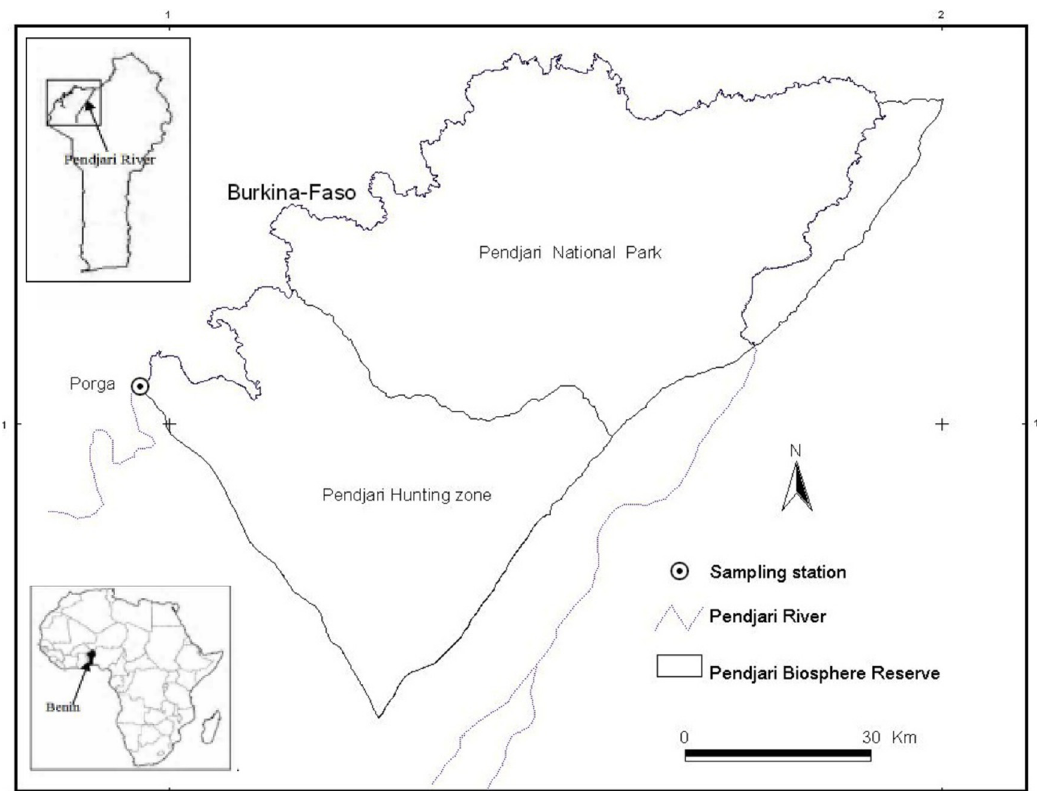
Fig. 1. Location of sampling station in the Pendjari River (Benin, West